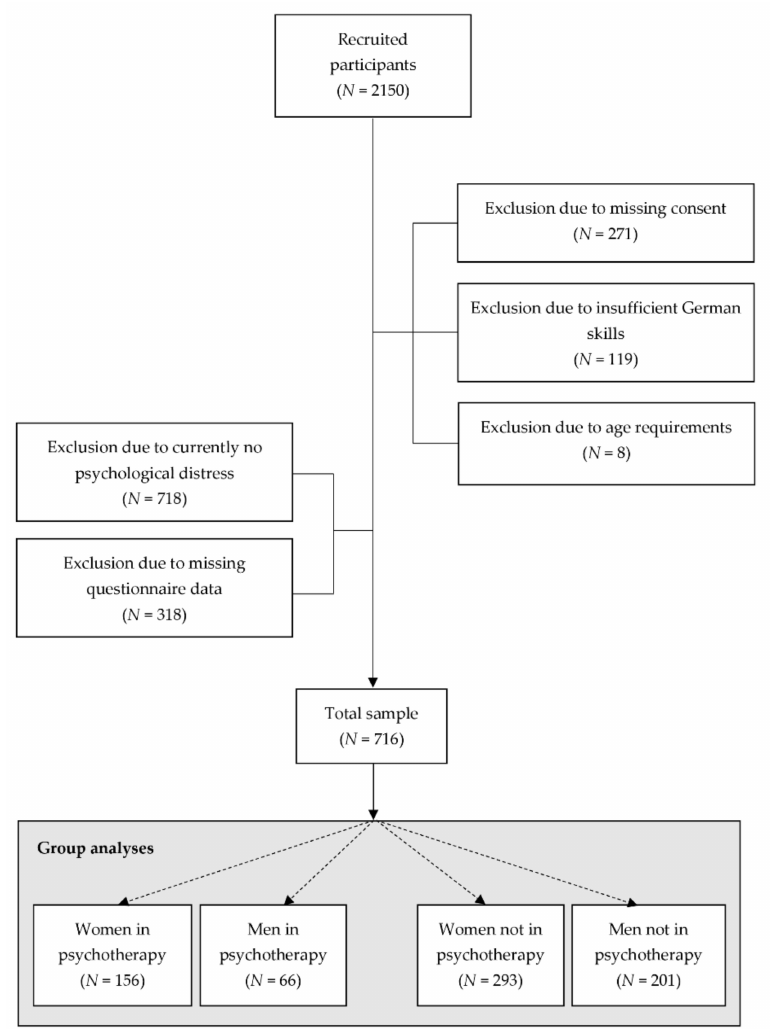
Figure 1. Flow diagram of the inclusion and exclusion process ( N = number of